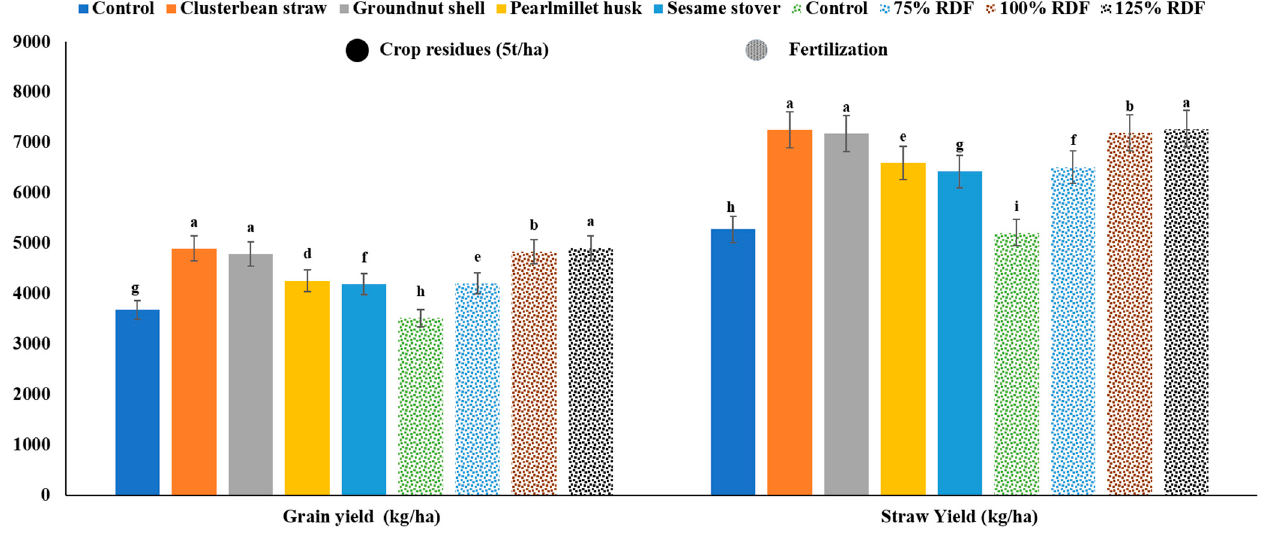
Figure 5. Interaction effect of crop residues and fertilization on straw yield of wheat.